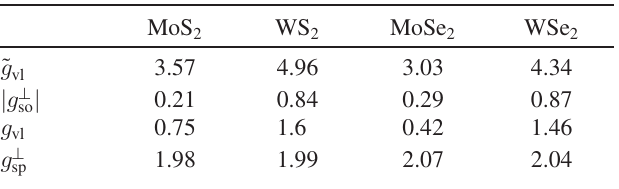
, g ) and spin ( g ⊥ vl vl